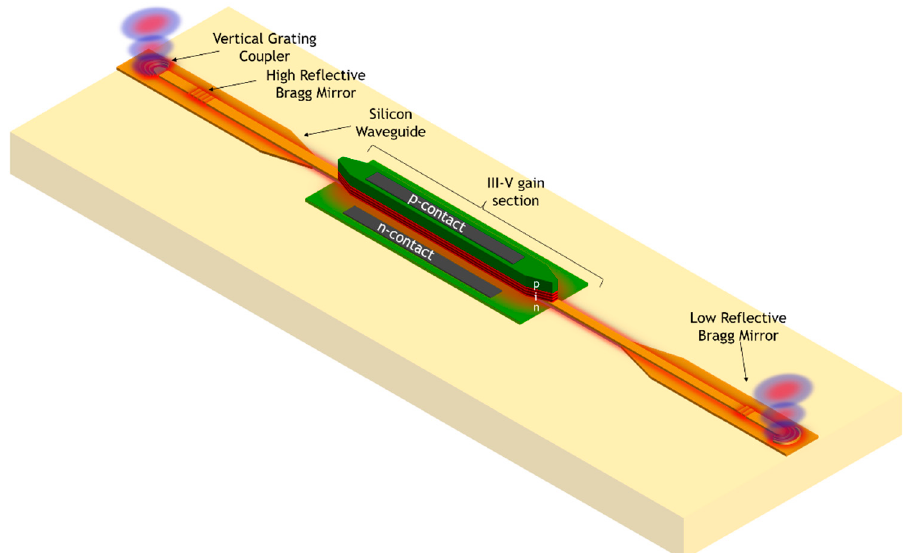
Figure 14. 3D Schematic view of the III-V on SOI DBR laser including a III-V gain region coupled to a Si waveguide, Bragg mirrors and vertical couplers.